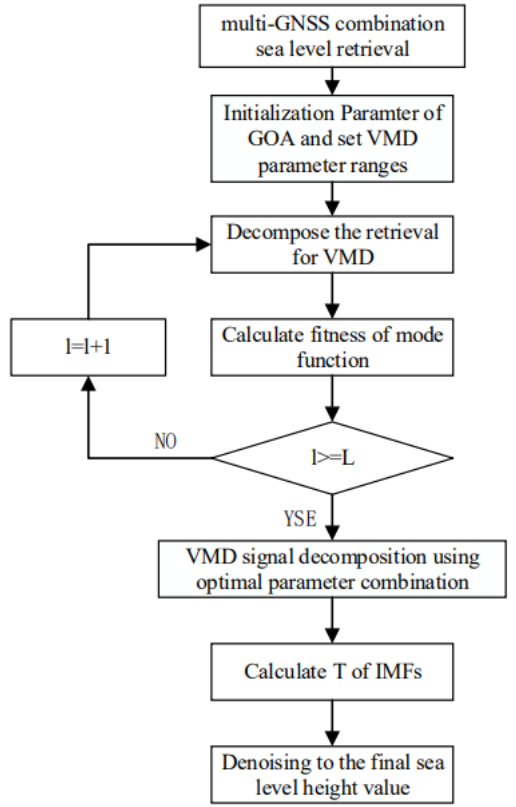
Figure 3. IVMD method flowchart based on multi-GNSS combination sea level retrieval.